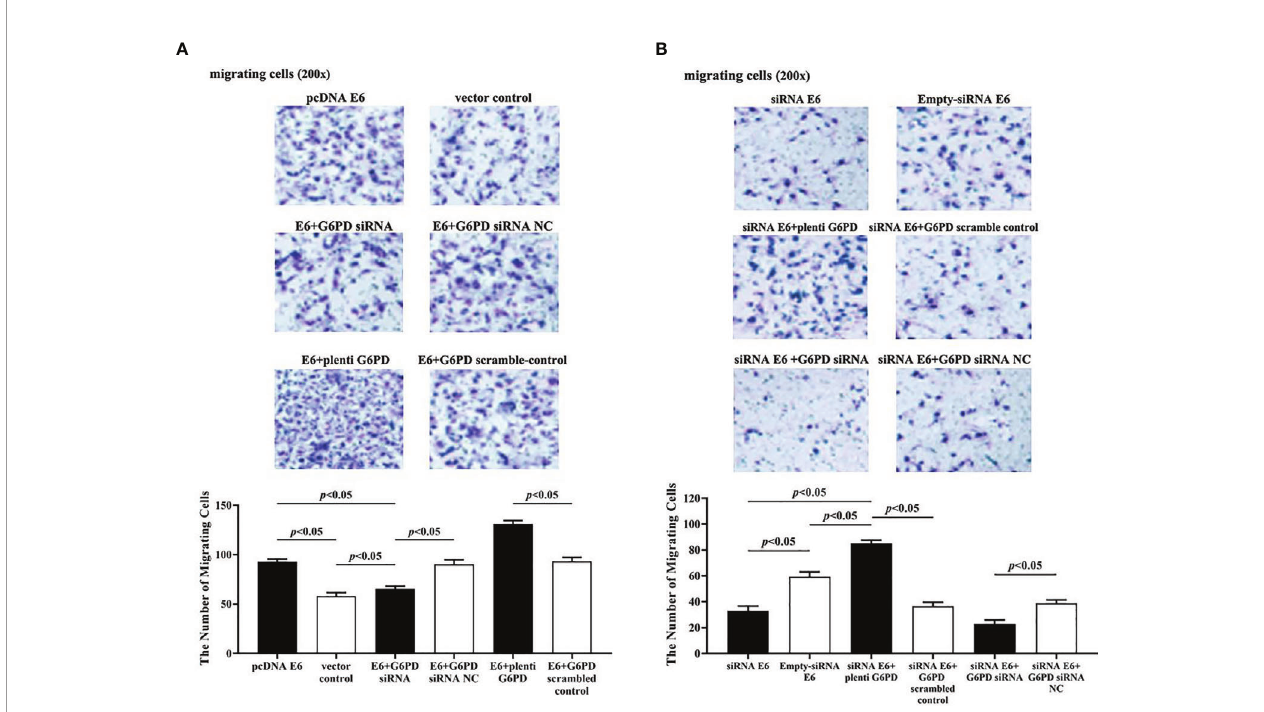
FIGURE 9 | HPV16 E6 promotes migration of HeLa cells by G6PD regulation. The staining of migratory cells with different transfections was observed under a microscope (200×). (A, B) Representative photographs and statistical plots of the quanti fi cation of migratory cells from six different treatment groups. Data are presented as means ± SD (n = 5).